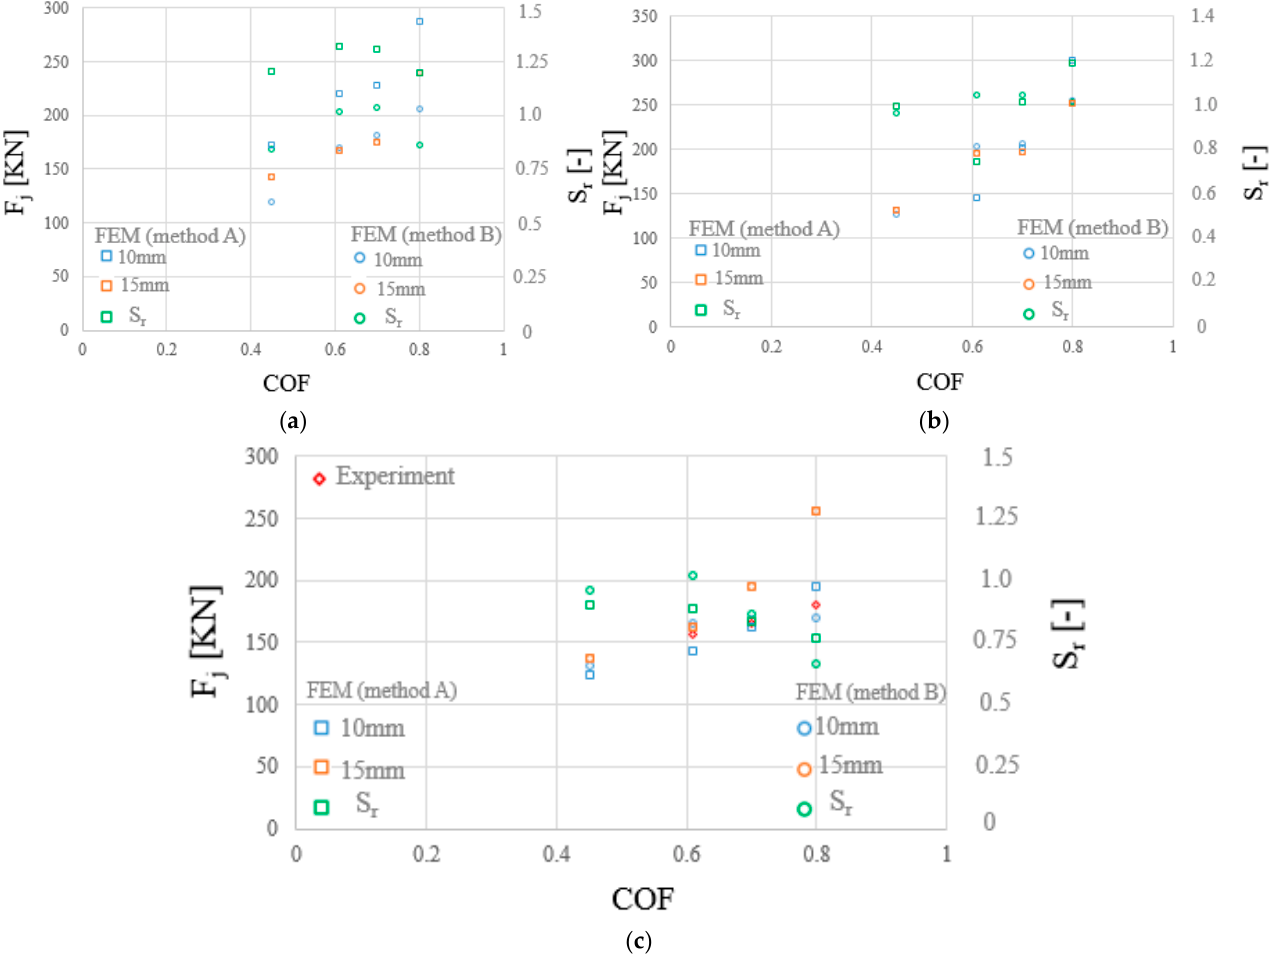
Figure 9. Joining force with different coefficients of friction (COF) in three geometries: ( a ) version 1, ( b ) version 2, and ( c ) version 3.